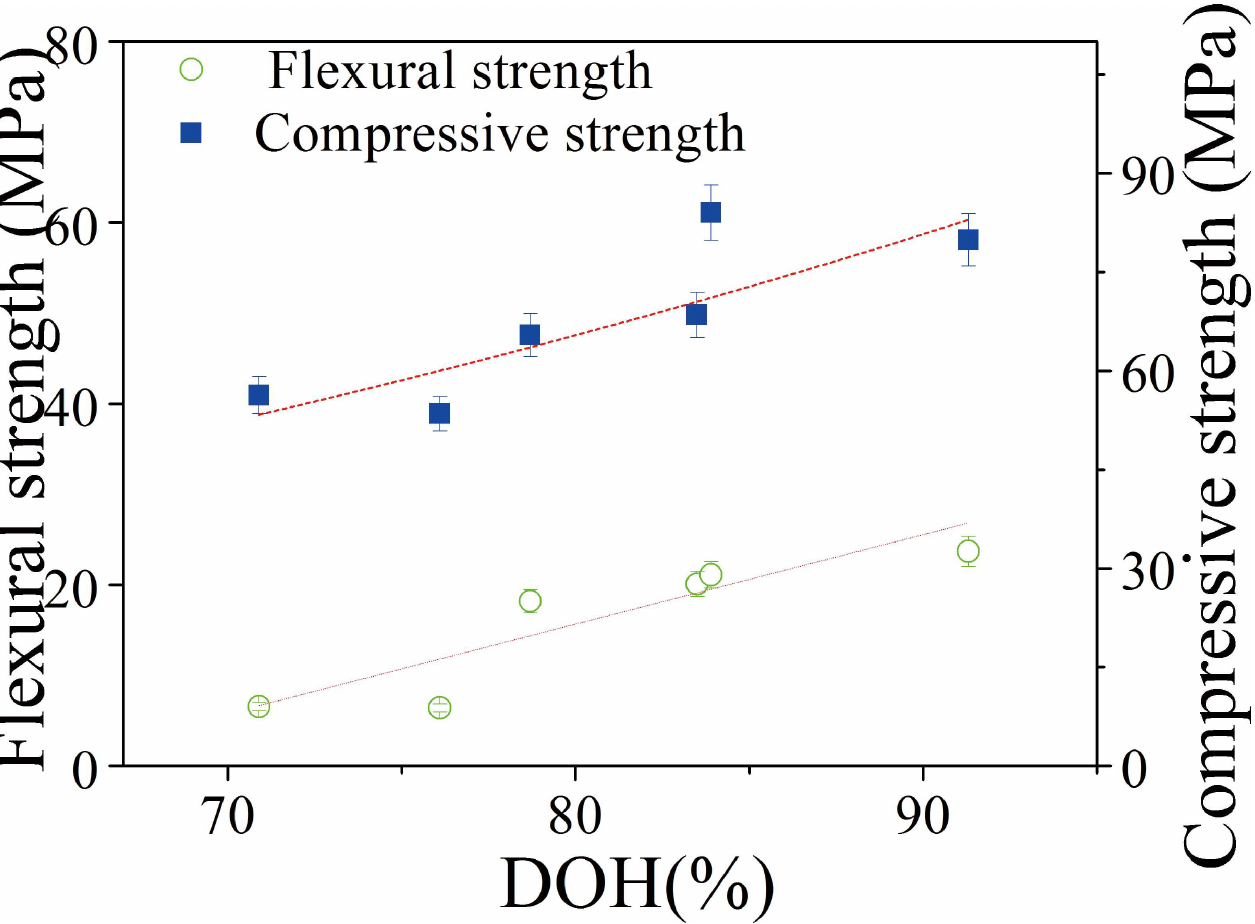
Fig 6. The relationship between mechanical strength (flexural strength and compressivestrength) and DOH.